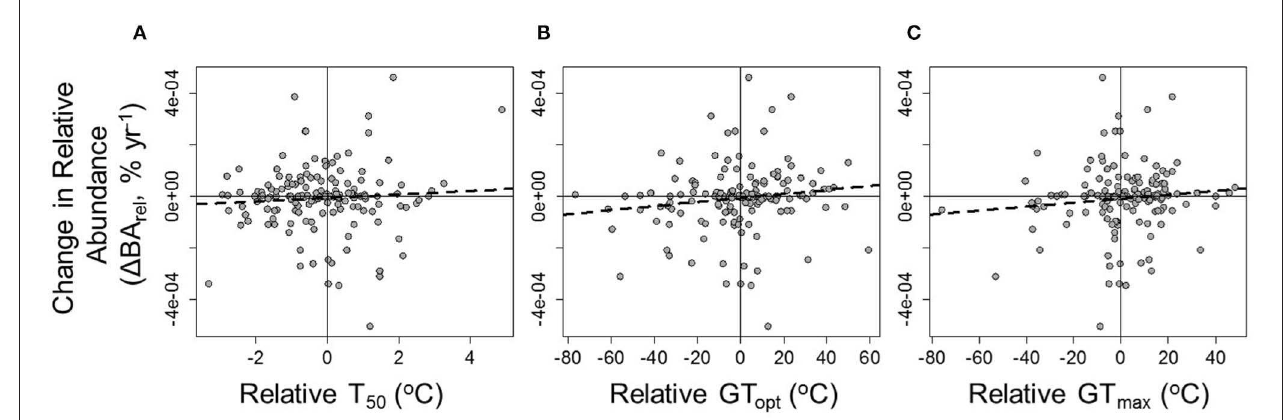
FIGURE 5 | The relationships between annual changes in species’ relative abundance ( 1 BA rel ) and (A) relative T 50 , (B) relative GT opt , and (C) relative GT max (see text). 1 BA rel = − 3.506e − 06 + 1.046e − 05 × T 50,relative , R 2 = 0.01, P = 0.218; − 7.945 e − 06 + 9.9960 e − 07 × GT max,relative , R 2 = 0.02, P =